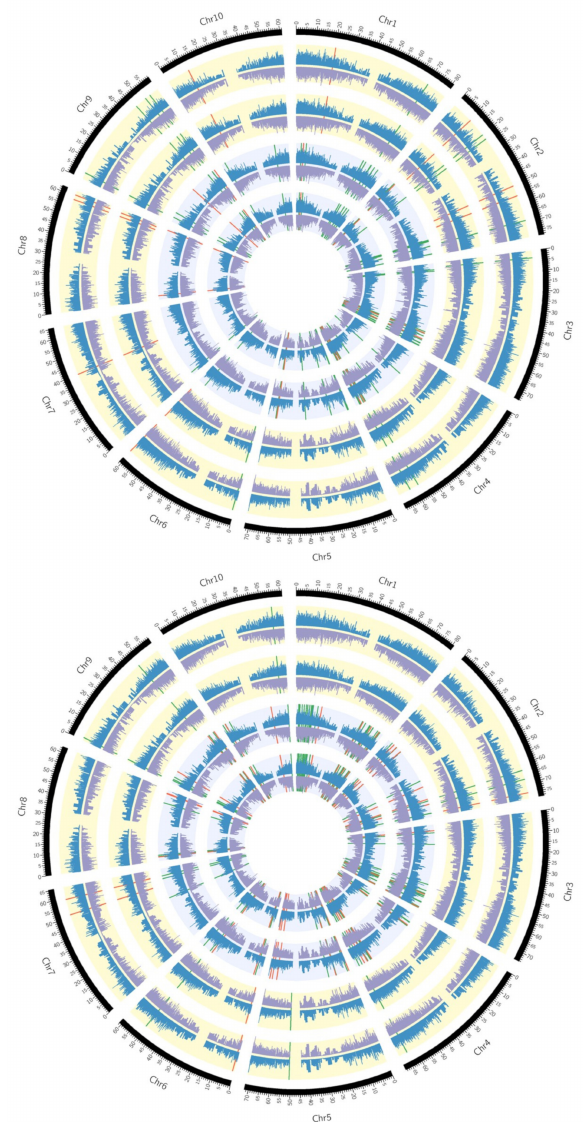
Figure 2. Genome-wide di ff erential gene expression in the drought-resistant (DR1 and DR2) and sensitive (DS1 and DS2) lines of sorghum at 1 h (top) and 6 h (bottom). Each slice represents one of the 10 sorghum chromosomes. From the center, the first four concentric circles represent sorghum lines DR1, DR2, DS1, and DS2 respectively. The outermost circle shows the genomic coordinates with a step size of 10 million bp. The gene expression levels are shown by blue and purple coverage plots for the control and treated samples, respectively. Across the coverage plots, the up-regulated and down-regulated genes unique to resistant (DR1 and DR2) and sensitive (DS1 and DS2) genotypes are marked by green and red lines,